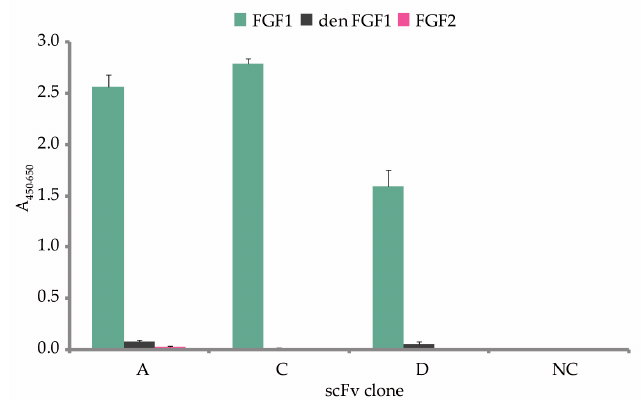
Figure 3. NMR binding assay. ( a ) Exemplary 15 N- 1 H HMQC NMR spectra of 15 N FGF1 (red) and the 15 N FGF1-scFvA complex (blue) (the protein/ligand ratio 1:1); and ( b ) representative 1D 1 H NMR spectra of FGF1 (red), scFvA (green), and the FGF1-scFvA complex (blue) (the protein/ligand ratio 1:1).